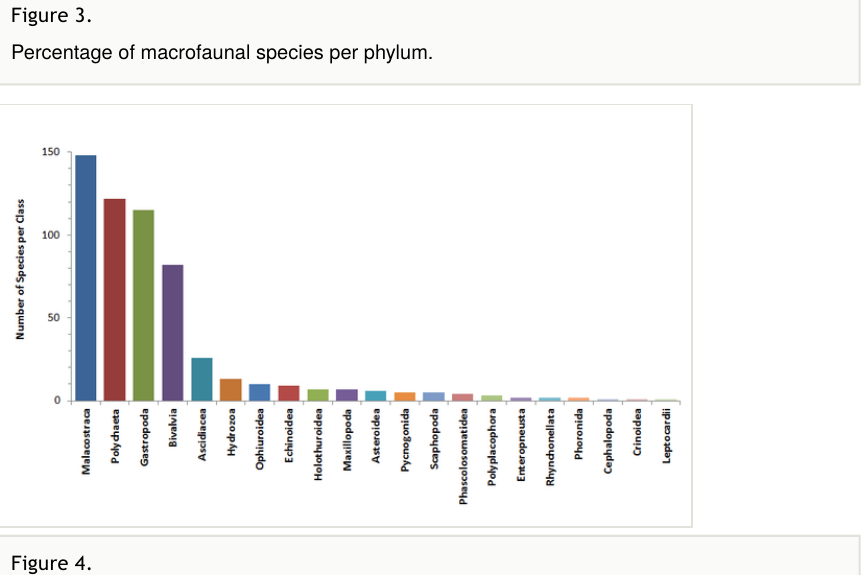
Figure 4. Number of macrofaunal species per